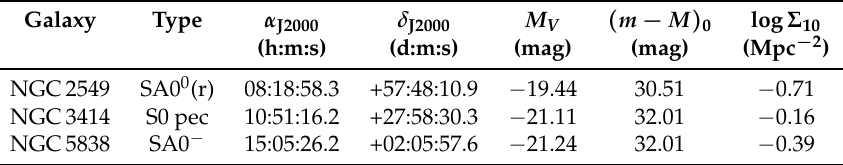
Table 1. Galaxy sample. Morphological type taken from the NASA/IPAC Extragalactic Database (NED), right ascension and declination (NED), V magnitudes from the RC3 catalogue, distance modulus of Tully et al. [16], Tonry et al. [17] and Theureau et al. [18] for NGC2549, NGC3414, and NGC5838, respectively. Last column indicates the mean surface density of galaxies inside a cylinder of height h = 600 kms − 1 centered on the galaxy which contains the 10 nearest neighbors